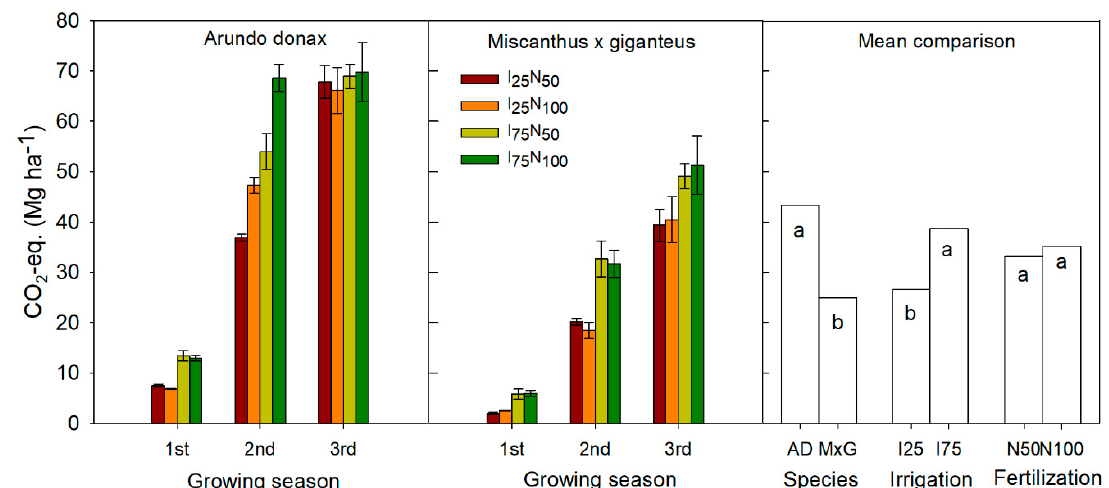
Figure 3. Aboveground CO 2 -sequestration (CO 2 -equivalent, Mg ha − 1 ) of Arundo donax and Miscanthus × giganteus throughout the experimental period and mean separation of main effects according to the Duncan’s post-hoc test. Different letters within main effect indicate statistical different mean ( p ≤ 0.05).